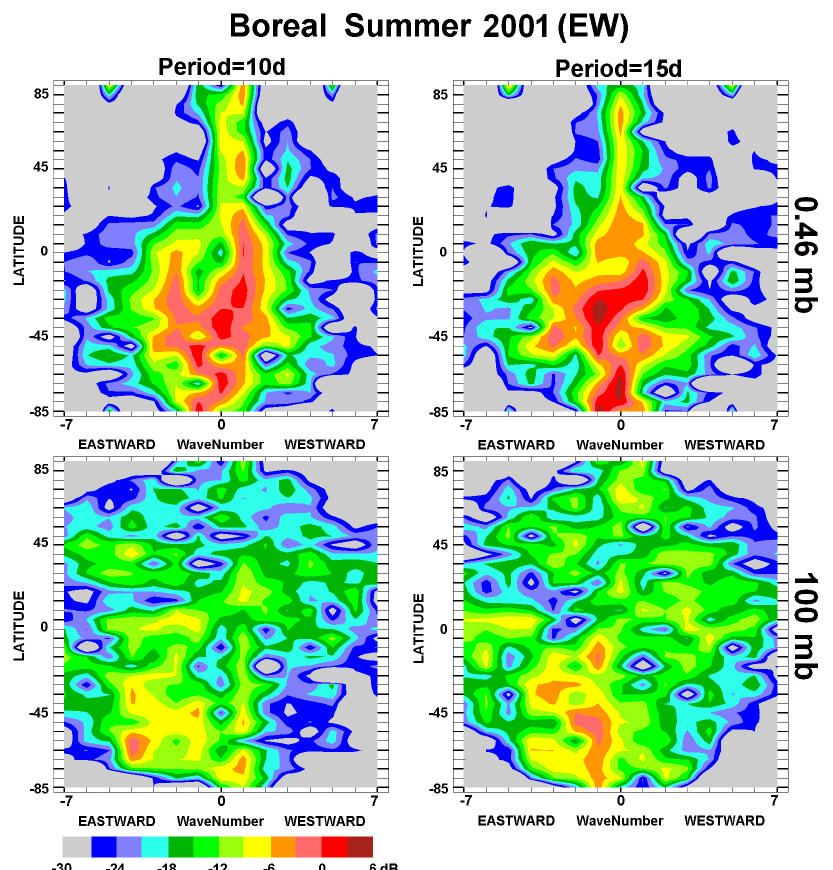
Fig. 11. Plots of wave number versus latitude for the oscillation with the period near 10 (left) and 15 (right) days in zonal (EW) wind components at 100mbar (at the bottom) and 0.46mbar (at the top) pressure levels during 2001 boreal summer (June − August 2001).